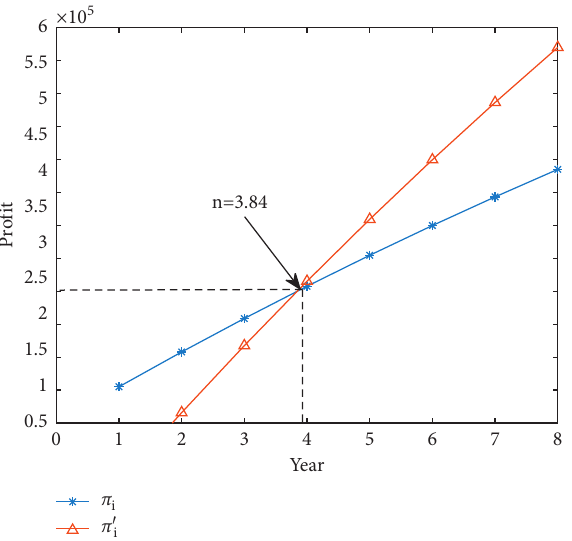
Figure 2: Profits of producers with q